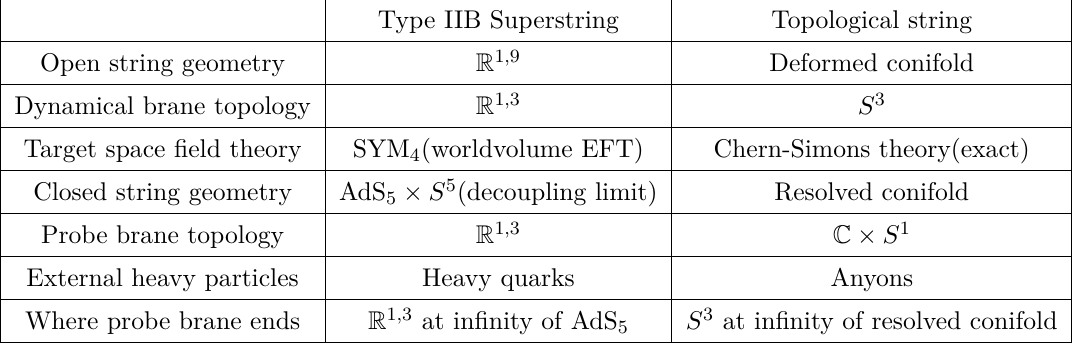
Table 1 . Open/closed duality for superstring and topological string